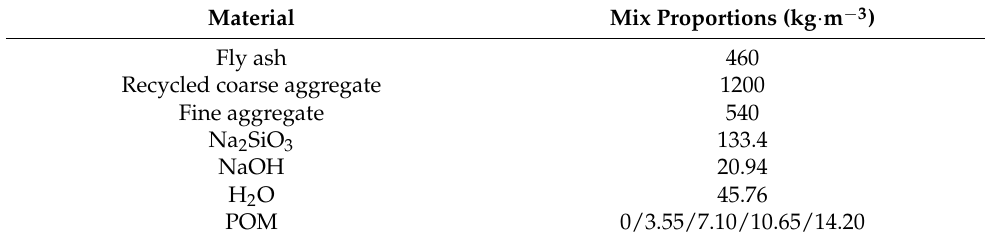
Table 2. Mix proportion design of PRGRC.